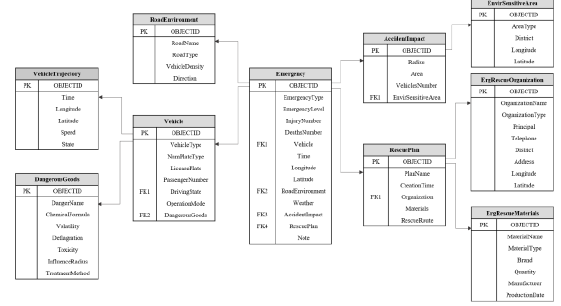
Figure 3. Main logical structure of data